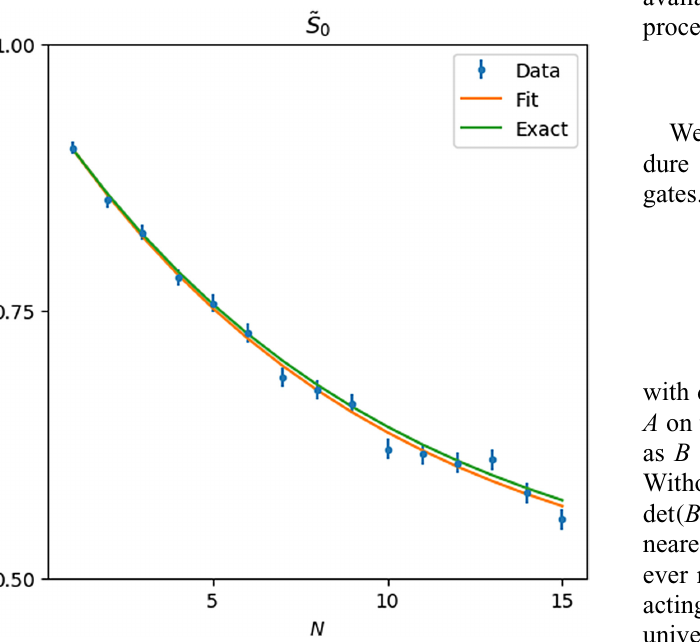
FIG. 5. The predicted and measured S 0 ( N ) for a single ran- domly generated error channel. The actual decay (green) is an exponential decay given by Eq. (18). We estimate S 0 ( N ) by applying random gates and measuring the final state (blue points). The data is fit to a function of the form of Eq. (18), from which we estimate L and S .